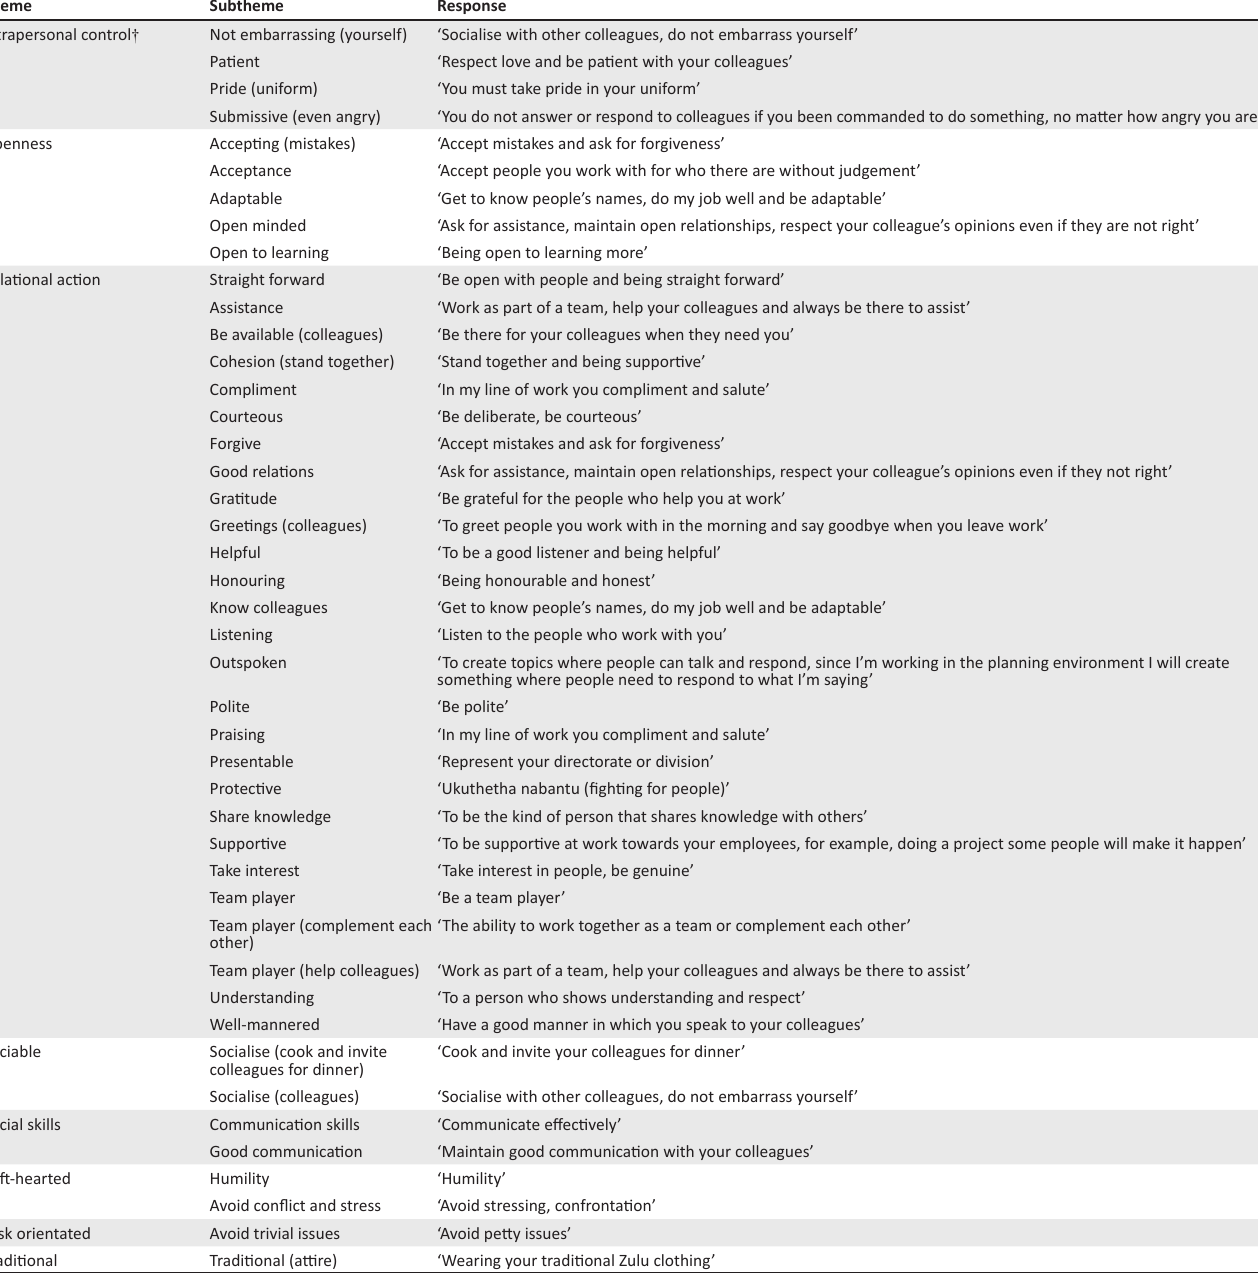
TABLE 1 (Continues...) : Impression management features used with